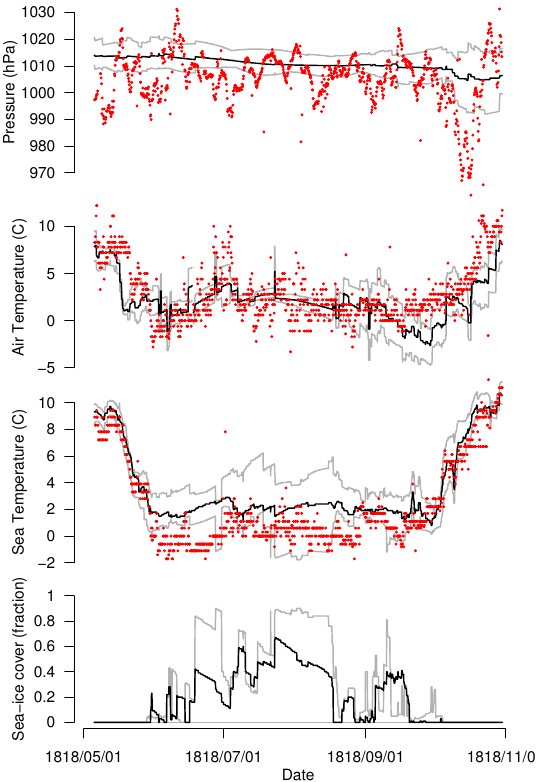
Fig.5. WeatherobservationsfromHMS Isabella ,comparedwithmodernvalues.Theredpointsaretheexpedition’sobservations,theblack andgreylinesarethemean,maxandminvaluesfrommoderndatasets(monthlyaveragesinterpolatedtodaily,1979-2004;SSTandsea-ice Fig. 5. Weather observations from HMS Isabella , compared with fromRayneretal.(2003),ATfromRigoretal.(2000),andpressurefromAllanandAnsell(2006)). modern values. The red points are the expedition’s observations, the black and grey lines are the mean, max and min values from modern datasets (monthly averages interpolated to daily, 1979–2004; SST and sea-ice from Rayner et al., 2003, AT from Rigor et al., 2000, and pressure from Allan and Ansell, 2006).